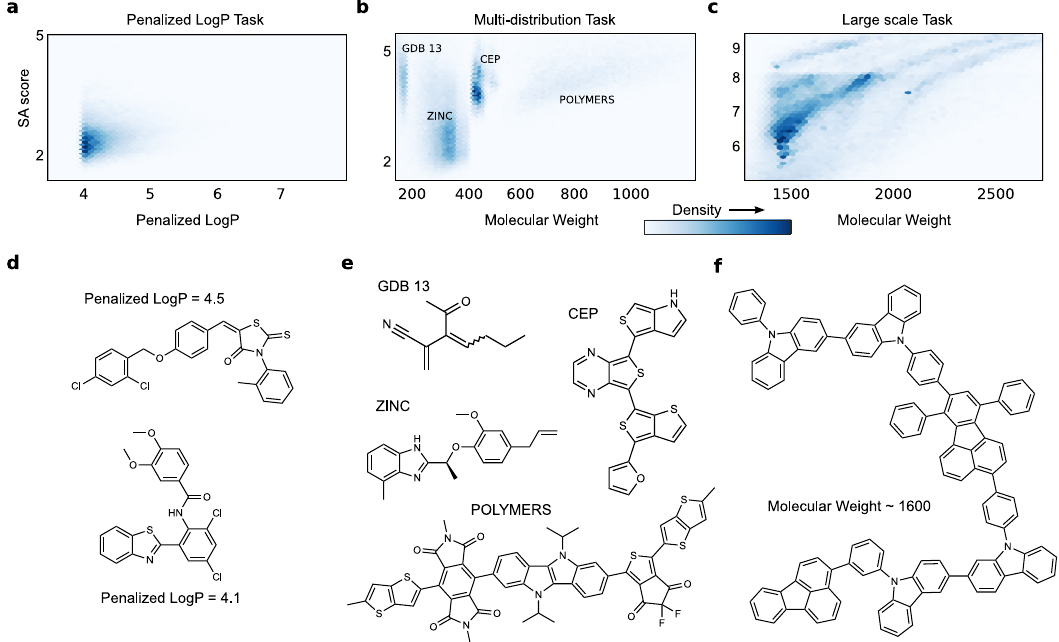
Fig. 1 The generative modeling tasks. a – c The molecular distributions de fi ning the three complex molecular generative modeling task. a The distribution of penalized LogP vs. SA score from the training data in the penalized logP task. b The four modes of differently weighted molecules in the training data of the multi-distribution task. c Large scale task ’ s molecular weight training distribution. d – f examples of molecules from the training data in each of the generative modeling tasks. d The penalized LogP task, e The multi-distribution task. f The large-scale